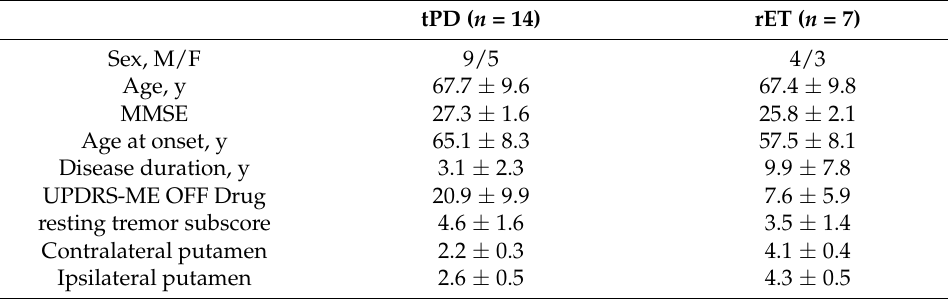
Table 1. Demographic and clinical data of tPD